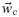
Flagellum beating.a) recorded image of an epimastigote showing the points that identify the centroid of the parasite body (w→c), the base of the flagellum (w→i), and its tip (w→f), all of which are used to compute the angle ϕ. b) Time evolution of angle ϕ in a typical trajectory. c) Power spectrum of the ϕ vs. t plot in b).